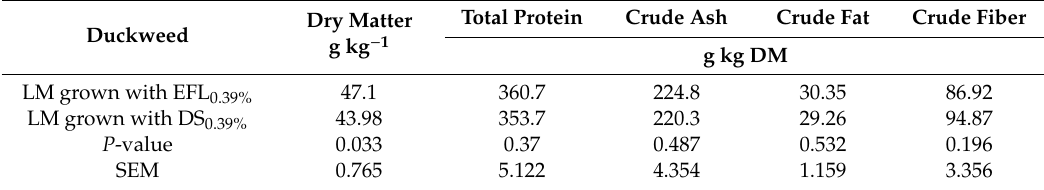
Table 4. Proximate composition of